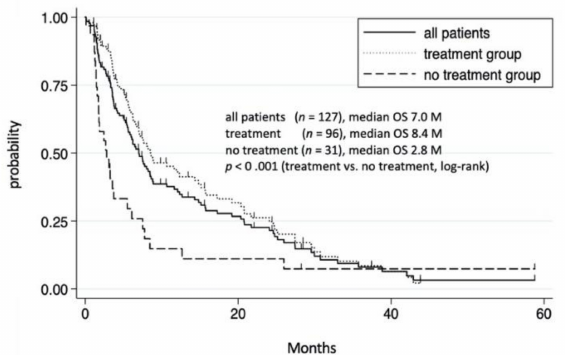
Figure 1. Cumulative survival rate of 127 HCC patients with extrahepatic metastases. Survival rates of all patients with extrahepatic metastases at 1 and 3 years were 36.4% and 7.9%, respectively. In treatment group, survival rates at 1 and 3 years were 43.5% and 8.6%, respectively. In the non- treatment group, survival rates at 1 and 3 years were 15.5% and 7.8%, respectively. Among the 127 patients with extrahepatic metastases, 96 received treatments, in- cluding TKI and/or conventional therapies, whereas the remining 31 received no treat- ment. Those who received no treatment had a significantly shorter OS than those who did ( p < 0.001). The median OS in the treatment and no treatment groups were 8.4 and 2.8 months, respectively, partially due to the unfavorable conditions in the no treatment group, including a poor liver function reserve and an advanced HCC stage (Table